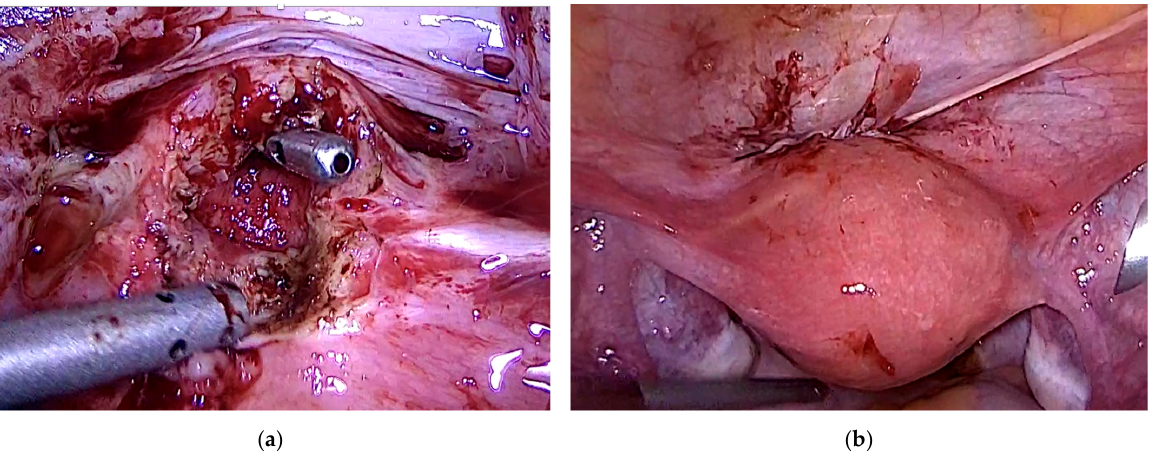
Figure 4. Laparoscopic treatment of symptomatic uterine niche pregnancy. ( a ) laparoscopic view of the uterine cervix after niche resection; ( b ) laparoscopic view after double layer suture of the uterine wall and the peritoneum.